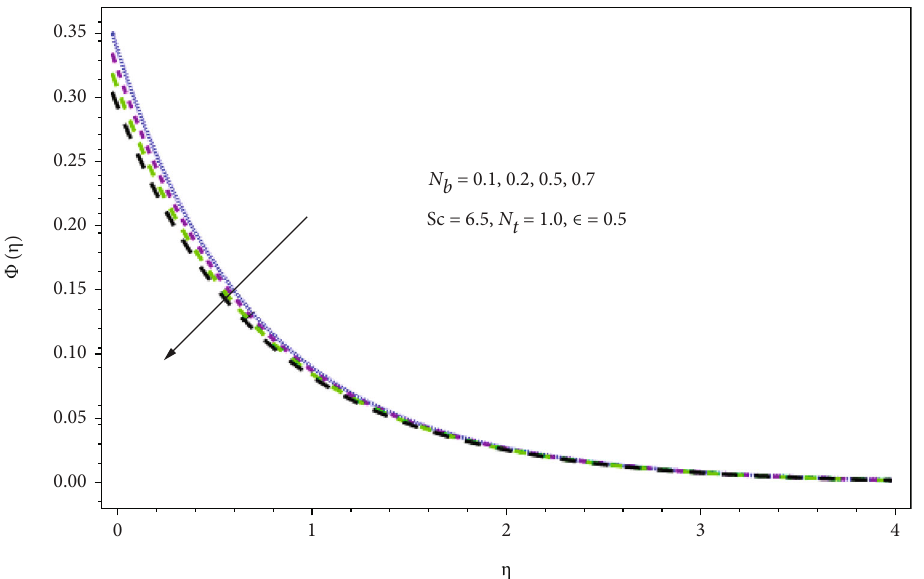
Figure 11: Representation of the e ff ect of N